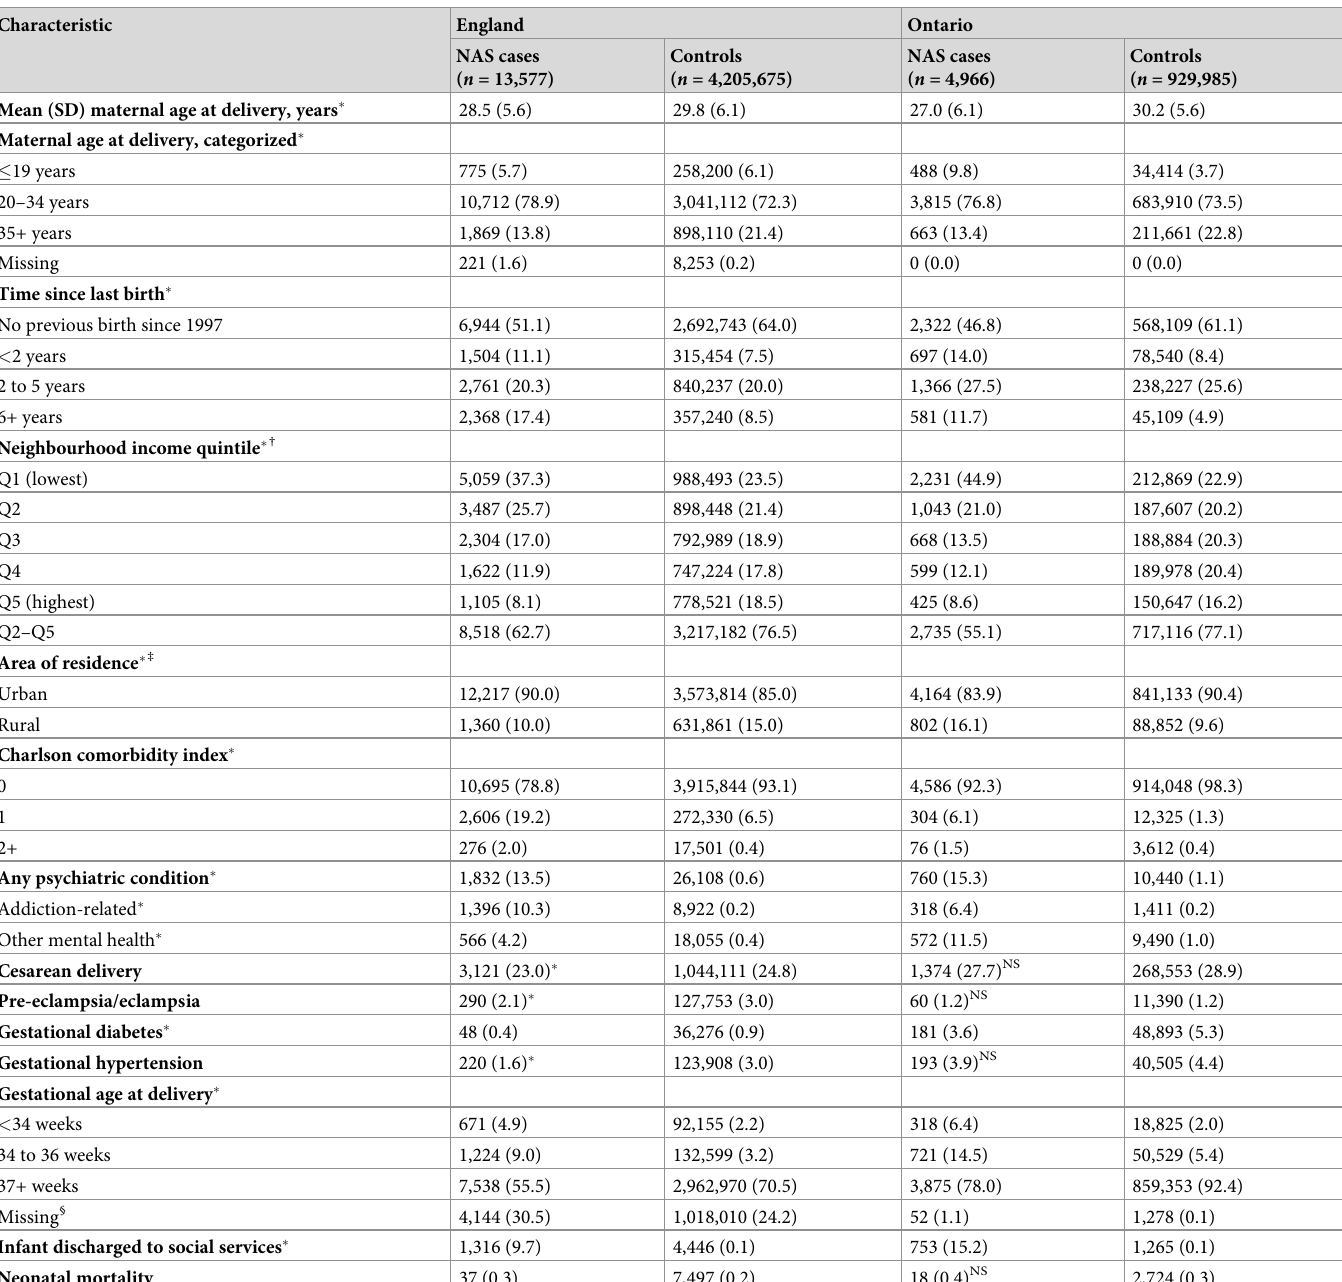
Table 2. Characteristics of mothers and infants at baseline, April 1, 2002 to December 31,